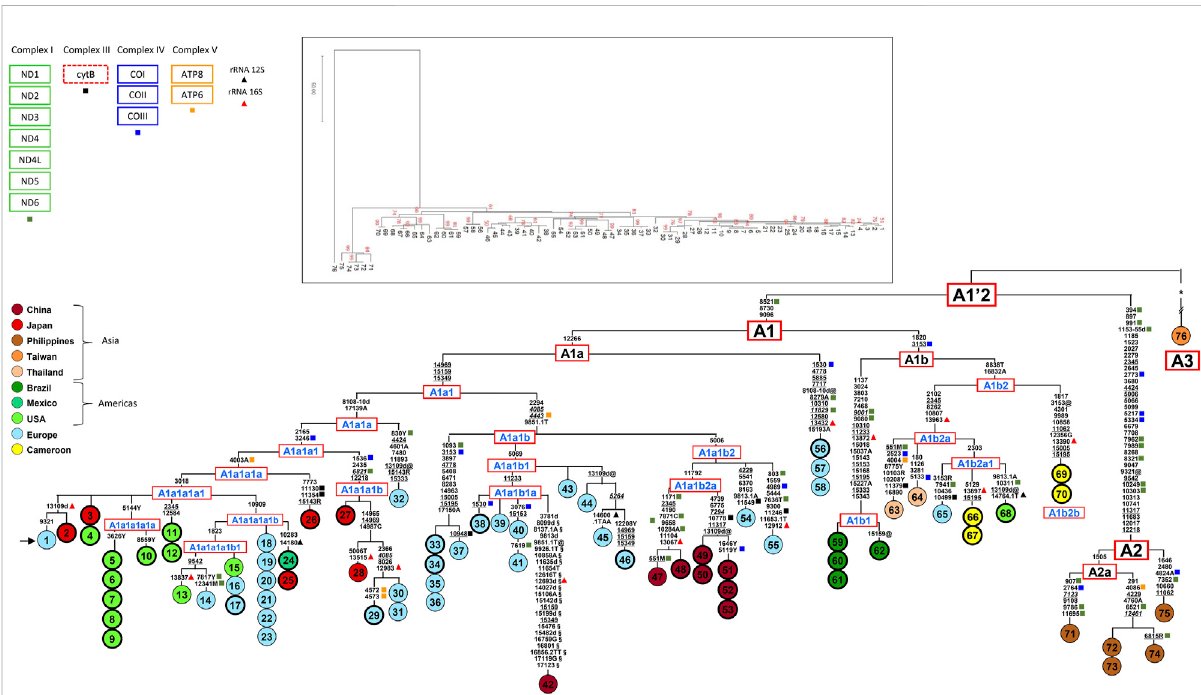
FIGURE 1 Phylogeny of Ae. albopictus mitogenomes. The tree encompasses 37 novel (circles marked by a thicker line) and 39 previously published sequences (24 from Battaglia et al., 2016, 1 from Zhang et al., 2015, 14 from Zé-Zé et al., 2020). The asterisk (*) refers to the 363 mutations (347 and 16 in the coding- and control-regions, respectively), listed in Supplementary Figure S1 (Battaglia et al., 2016), separating mitogenome #76 from the A1 ’ 2node. For thephylogeny construction,theentire coding-regionvariation ofall mitogenomes wasincluded aswellas somecontrol-region mutations (from np 14897 to np 15350 and from np 16831 to np17150). The mitogenome from a mosquito of the Italian Rimini strain (#1, marked by the arrow) was employed to number the mutations shown on the branches. Mutations are transitions, unless a base is appended to indicate a transversion(toA,G,C,orT),orasuf fi xforindels(1,d).HeteroplasmicpositionsareindicatedusingtheIUPACnucleotidecode.Recurrentmutations within the phylogeny are underlined (and in italics if present in mitogenome #76) and back mutations are marked with the suf fi x @. The numerous mutations shared only by the published mitogenomes #42 and #76 are marked with the suf fi x §. Sequences from Portugal (Zé-Zé et al., 2020) are from np 283 to np 14702; mutations out of this range were inferred according to their position in the tree. Colours illustrate geographic origins. Lengthvariation(insertions/deletions)inpolynucleotidestretchesbeginningatnps3808,8134,and17140werenotconsidered.Haplogroupsinblue are new relative to Battaglia et al., 2016. Non-synonymous mutations are indicated with squares, with colours matching the protein-coding gene complexes (top left in the fi gure); mutations in 12S and 16S rRNA genes are shown too, with blue and red diamonds. The MP tree is shown in the top inset; branch lengths are not proportional to molecular